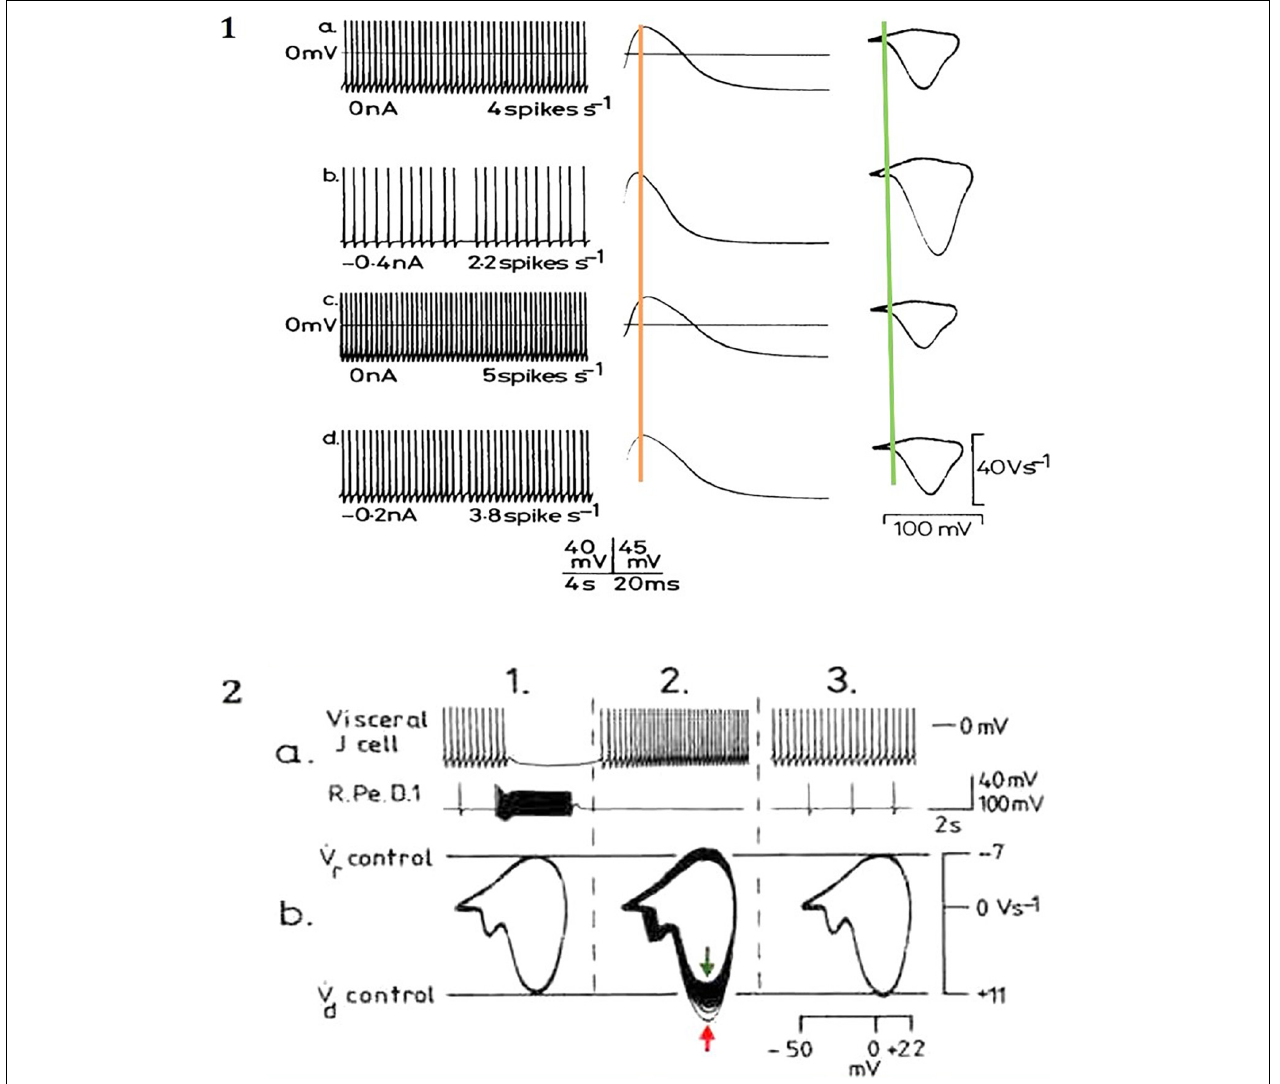
FIGURE 4 | Modulation of action potential frequency, shape and trajectories from identified Lymnaea neurons by (A) depolarising currents and (B) inhibitory synaptic inputs. (A) In a right pedal A (RPeA) cluster neuron, action potential frequency, shape and phase plane trajectory are modified by maintained depolarizing and hyperpolarizing currents, which modify the action potential properties. All spikes in the traces at left are superimposed in the middle trace and in the phase plane portraits at right. Note how the action potential peak at ˙ V d shifts either side of the superimposed orange line, while threshold (superimposed green line) remains temporally constant and ˙ V d is even more clearly variable in the phase plane representations. Similar effects are produced by excitatory and inhibitory synaptic inputs (adapted from Winlow et al., 1982 with permission). (B) Effects of monosynaptic i.p.s.p.s from the giant dopamine-containing neuron, RPeD1 (right pedal dorsal 1), on visceral J cell action potentials (for detail see Winlow and Benjamin, 1977). (a) Upper trace, J cell; lower trace RPeD1 (ac coupled and filtered). (b) Phase plane portraits of J cell action potentials: 1. pre-control; 2. phase plane portraits of 32 successive action potentials (peak of spike 1 denoted by red arrow, spike 3 by green arrow); 3. post-control of the last 10 action potentials shown above. After inhibition by RPeD1 both ˙ V d and ˙ V r were increased, but as the cell accelerated following inhibition both ˙ V d and ˙ V r declined below control values (adapted from Winlow, 1987, with